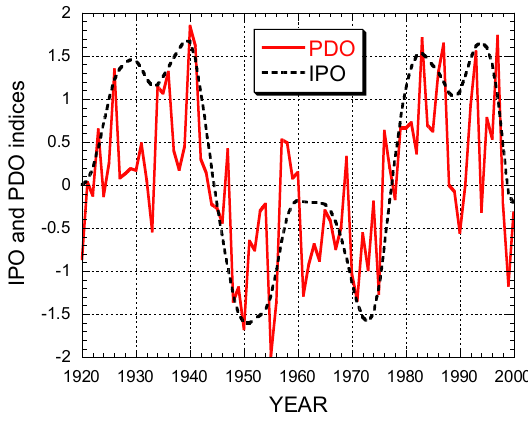
Figure 2. IPO/PDO indices. 3